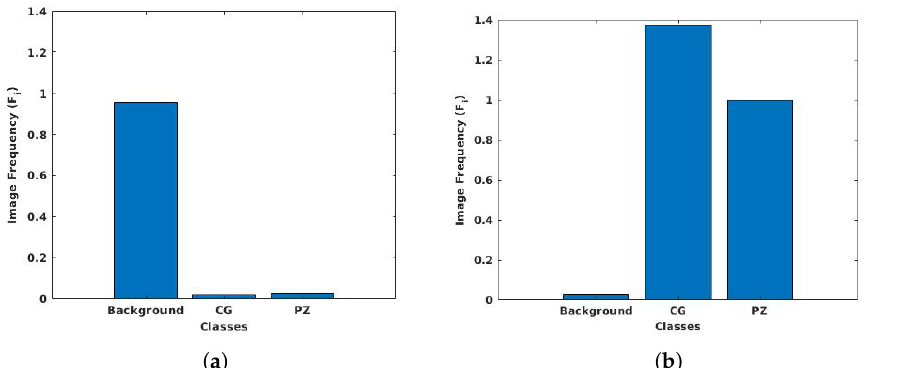
Figure 4. Pixel distribution of ( a ) original images and ( b ) after class weighting for the NCI-ISBI 2013 dataset.